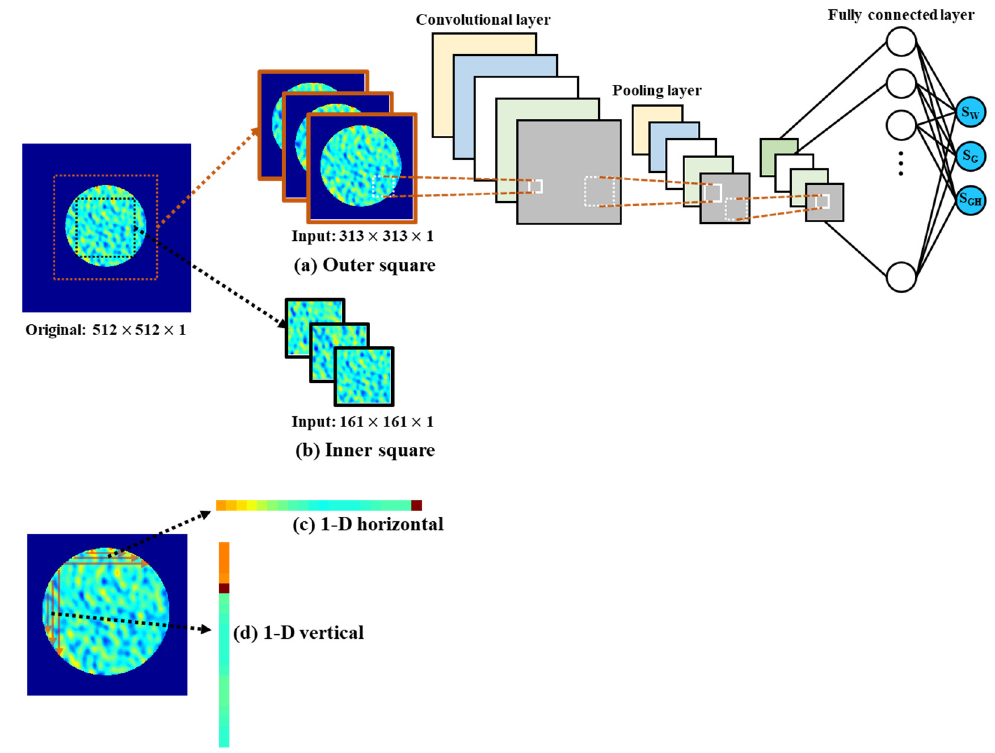
Figure 8. A schematic diagram of the CNN application with different input data in the CT image. ( a ) the first option to construct input data and it is the largest amount of data compared to the rest of three options; ( b ) the second option to construct input data with only inner area from the outer square; ( c ) the third option for input data in one dimension and it attaches pixels in horizontal direction; ( d ) the fourth option for input data constructed in vertical direction.